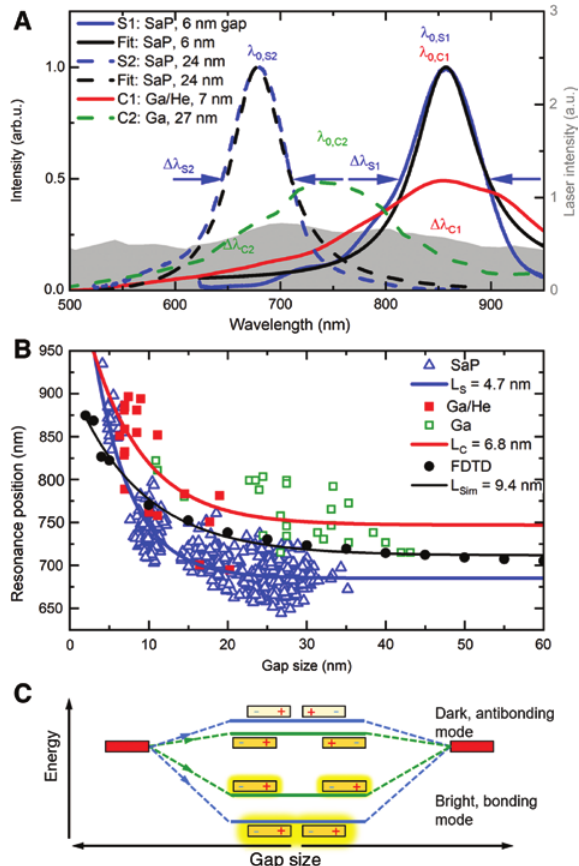
Figure 2: Resonance positions. (A) Linear scattering spectra of prototypical dimer antennas with dimensions of 90 × 35 × 30 nm 3 fabricated using sketch and peel lithography (SaP, blue) with gap sizes of 6 nm (solid line) and 24 nm (dashed line), gallium (Ga, green, 27 nm), and gallium/helium (Ga/He, red, 7 nm) lithography. The black lines show Lorentzian line shape fits to the SaP scattering spectra. The spectrum of the excitation laser is shown as a grey-shaded background. (B) Resonance position λ of dimer antennas fabricated using SaP 0 (blue triangles), Ga (green squares), and Ga/He (red squares) as a function of gap size. Results from FDTD simulations (black circles) and from a quasi-static model (light-blue diamonds) are compared to exponential gap size dependencies of the resonance position with decay lengths of 4.7 nm (blue), 6.8 nm (red), and 9.4 nm (black). (C) Schematic energy-level diagram of the LSPR mode for dimer antennas with different gap sizes. A decrease in gap size (green and blue lines) results in a red shift of the bright, bonding